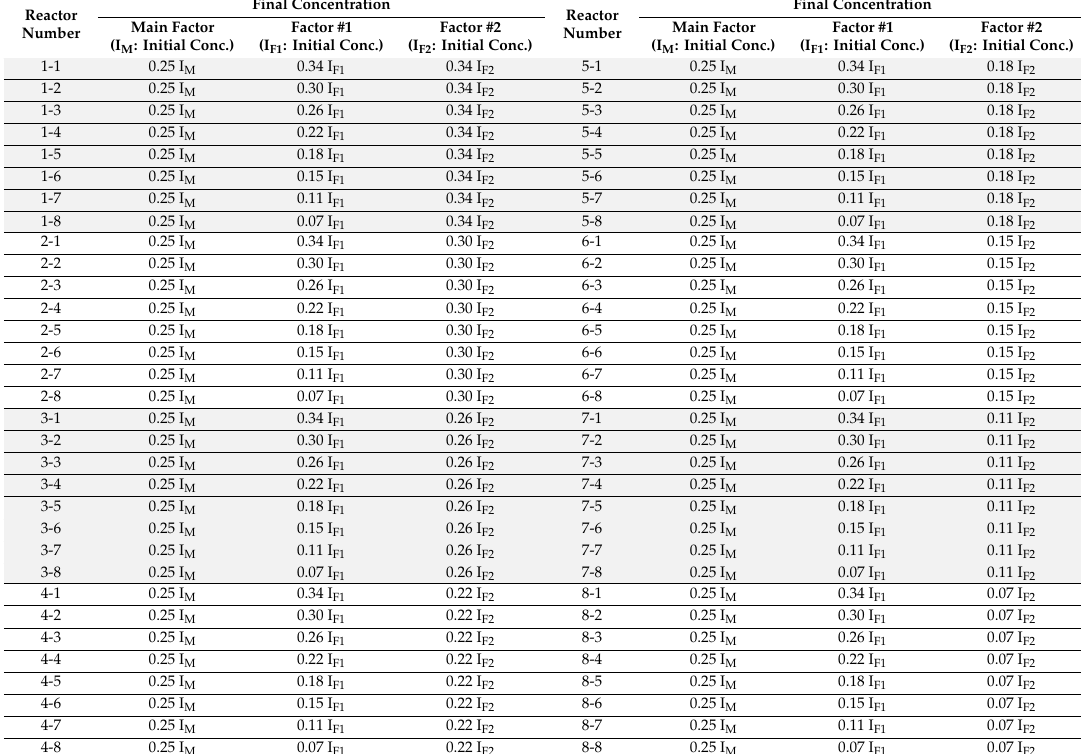
Table 1. Compositions and combinations of the reagents in the 64 microfluidic incubation chambers. Final Concentration Reactor Number